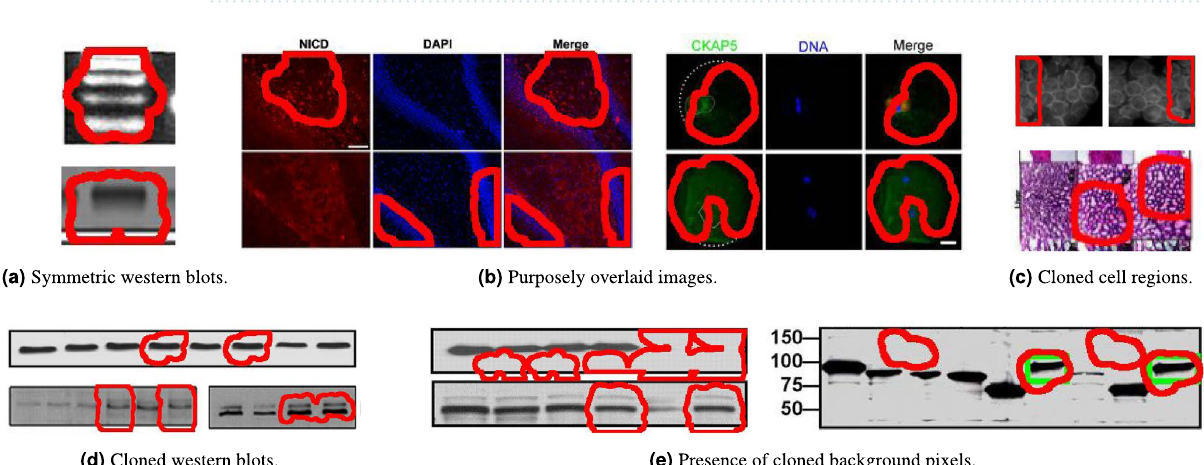
Figure 6. Results of copy-move detection that are not mentioned in existing retraction notices. Regions with red borders depict the cloned content found by SILA. Many of these regions do not present a respective ground-truth green box because they have never been acknowledged in a retraction notice. In ( a ), cloned regions detected due to the perfectly symmetric nature of some western blots. In ( b ), cloned regions detected due to panel overlays. In ( c ), cloned regions over microscopy outputs that might have been difficult for a human reviewer to spot in the past. In ( d ), more of these hard-to-spot regions, this time on western blots. In ( e ), cloned background pixels, among others. When SILA finds a cloned region, it does not mean there was necessarily a mistake or misconduct. Examples in ( a ) and ( b ) are probably legitimate and highlight the importance of human intervention when deciding if cloned content is acceptable or not. Analysts have probably overlooked the issues depicted in examples ( c – e ). All original panels within this figure belong to papers published as Creative Commons content, under DOI ( a , top) https:// doi. org/ 10. 1074/ jbc. M8060 41200, ( a , bottom; d , bottom) https:// doi. org/ 10. 1074/ jbc. M111. 255042, ( b , left; e ) https:// doi. org/ 10. 1074/ jbc. M8080 84200, ( b , right) https:// doi. org/ 10. 18632/ oncot arget. 15097, ( c top; d top) https:// doi. org/ 10. 1074/ jbc. M111. 274613, and ( c bottom) https:// doi. org/ 10. 3389/ fphar. 2016. 00226. Here, they were cropped, enlarged, and annotated over, in either green or red, to convey the findings of